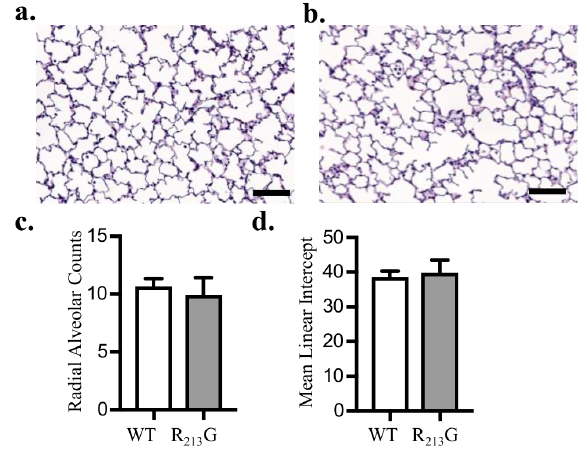
Figure 3. Mice expressing the R 213 G SNP exhibited normal alveolar development. Representative images of H & E stained lung in 22-day old ( a ) WT and ( b ) R 213 G control mice, scale bar = 100 μ m. ( c ) Radial alveolar counts in control WT and R 213 G mice p > 0.05 by unpaired t -test, n = 7–8 ( d ) Mean linear intercepts in control WT and R 213 G mice. p > 0.05 vs. WT PBS by unpaired t -test, n = 6–8.